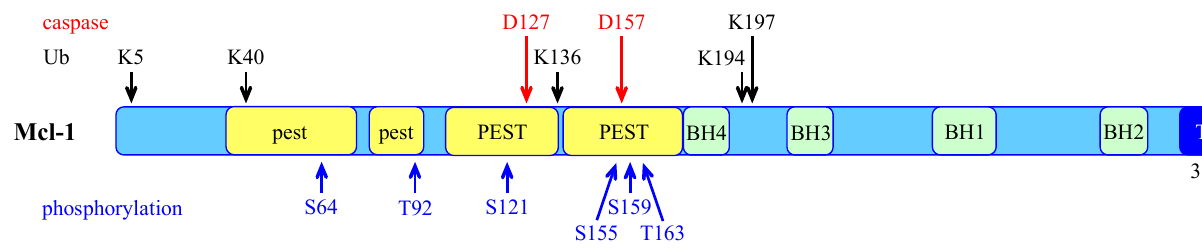
Figure 2. Schematic representation of the human Mcl-1 protein showing the functional regions and post-translational modification sites. These include the transmembrane domain (TM), Bcl-2 homology domains (BH1-4), weak (lower case) and strong (upper case) PEST sequences, sites of ubiquitination (Ub), caspase cleavage and phosphorylation